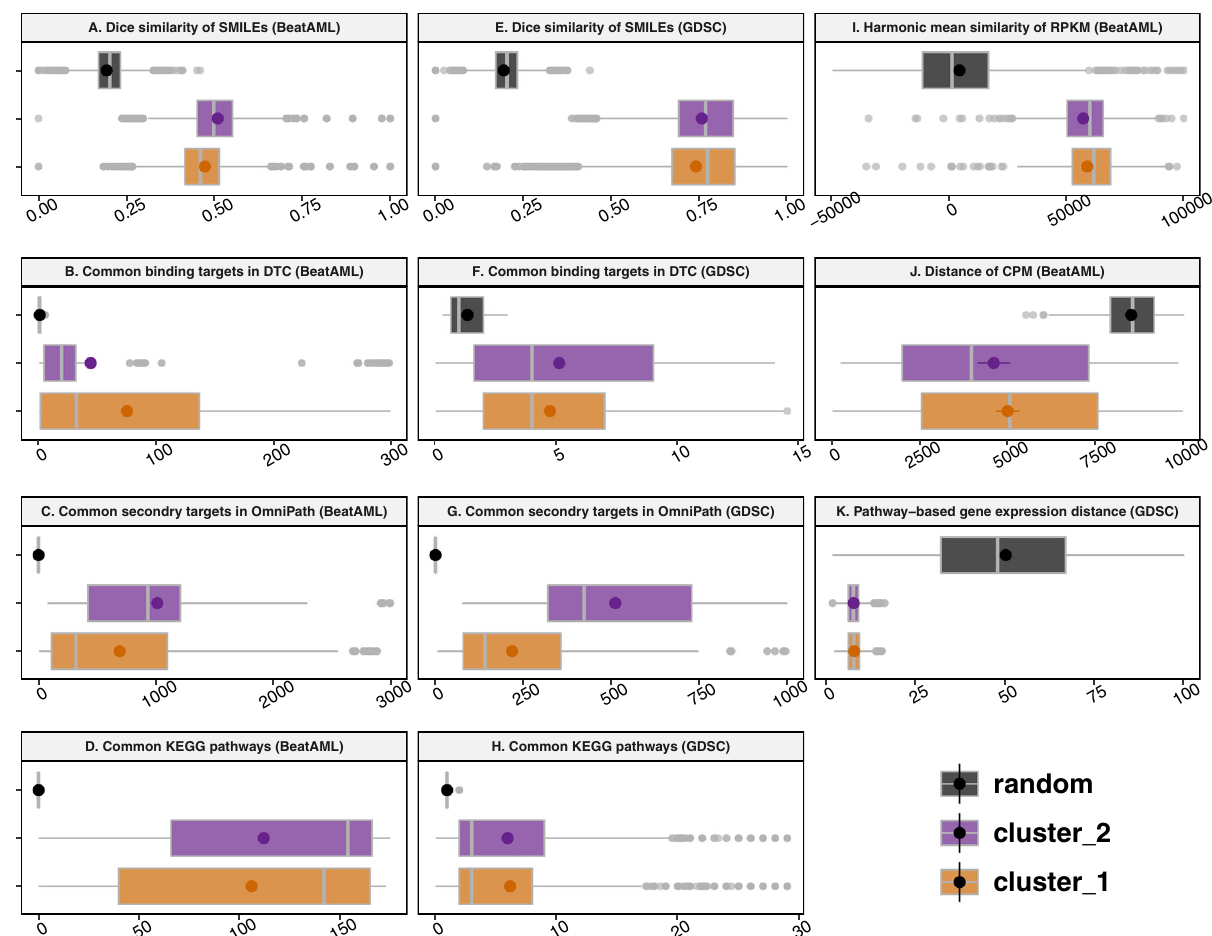
Fig. 5 Beat AML and GDSC intra-cluster homogeneity analysis. A The distribution of SMILE structure similarities ( n = 10,000), B the distribution of pairwise intersection size of immediate binding protein targets based on the DTC database ( n = 814), C secondary targets in the OmniPath database ( n = 1524), and D corresponding KEGG pathways are shown for the DSN clusters compared to random grouping in Beat AML dataset ( n = 340,000). Similarly, for the GDSC dataset, E the distribution of SMILE structure similarities ( n = 15,160), F the distribution of pairwise intersection size of immediate protein targets based on DTC database ( n = 1257), G secondary targets in the OmniPath database ( n = 4222), and H associated KEGG pathways are depicted for DSN clusters compared to random grouping ( n = 17,300). The intra-cluster homogeneity analysis was performed for PSN based on gene expression. I The distribution of similarity of patients ’ RPKM ( n = 542), J the distribution of distances of patients ’ CPM in the Beat AML dataset ( n = 405), and K the distribution of distances of pathway-based activity scores in the GDSC dataset are represented ( n = 84,485). The coloured dots and the lines in the centre of the boxplots denote the mean and median, respectively, while the left and right hinges indicate the 25th and 75th percentiles, respectively. The left and right whiskers represent values that are no more than 1.5 times the interquartile range (IQR). The points outside the whiskers are outlier predictions. Source data are provided as a Source Data fi